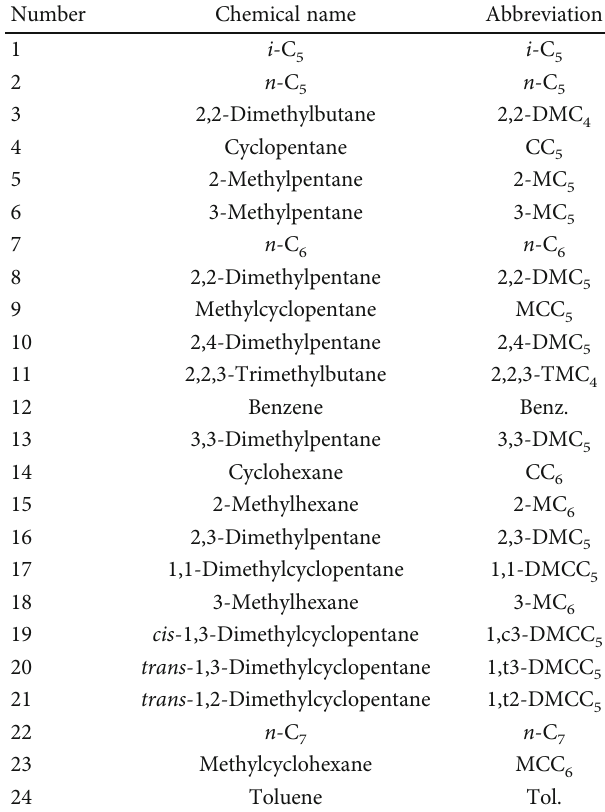
-C ) in natural gas from the western Qaidam Basin. The numbers and 5 7 Table 2: Number and the corresponding light